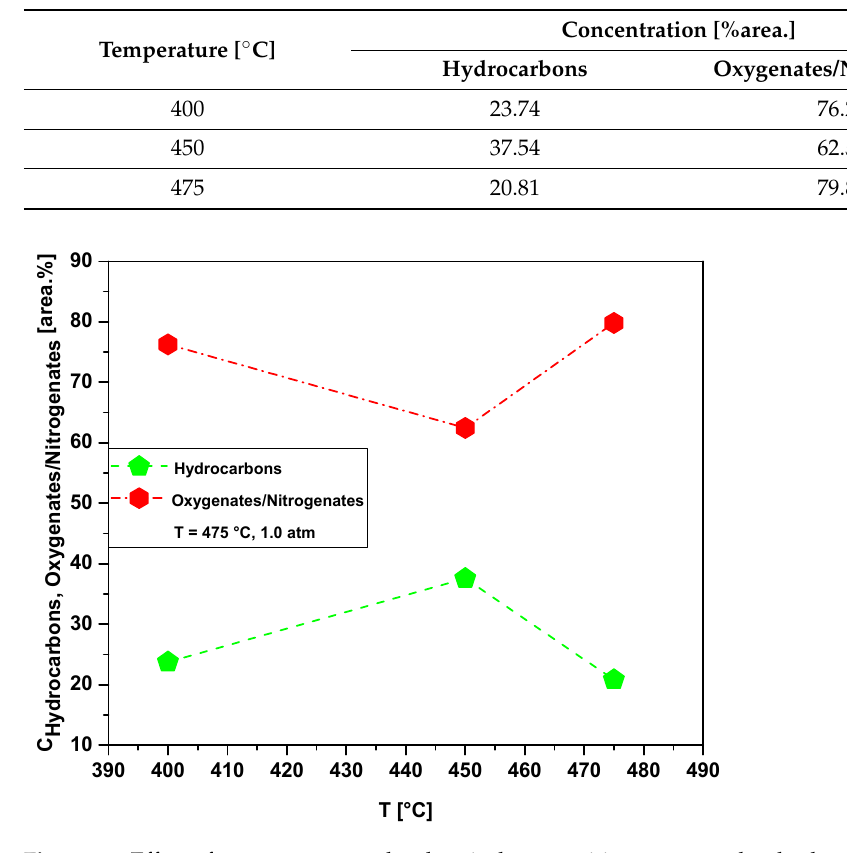
Figure 23. Effect of temperature on the chemical composition, expressed as hydrocarbons and oxy- genates/nitrogenates, of bio-oils obtained by pyrolysis of MHSW fraction (organic matter + paper) at 400, 450, and 475 °C, 1.0 atm, in laboratory scale.